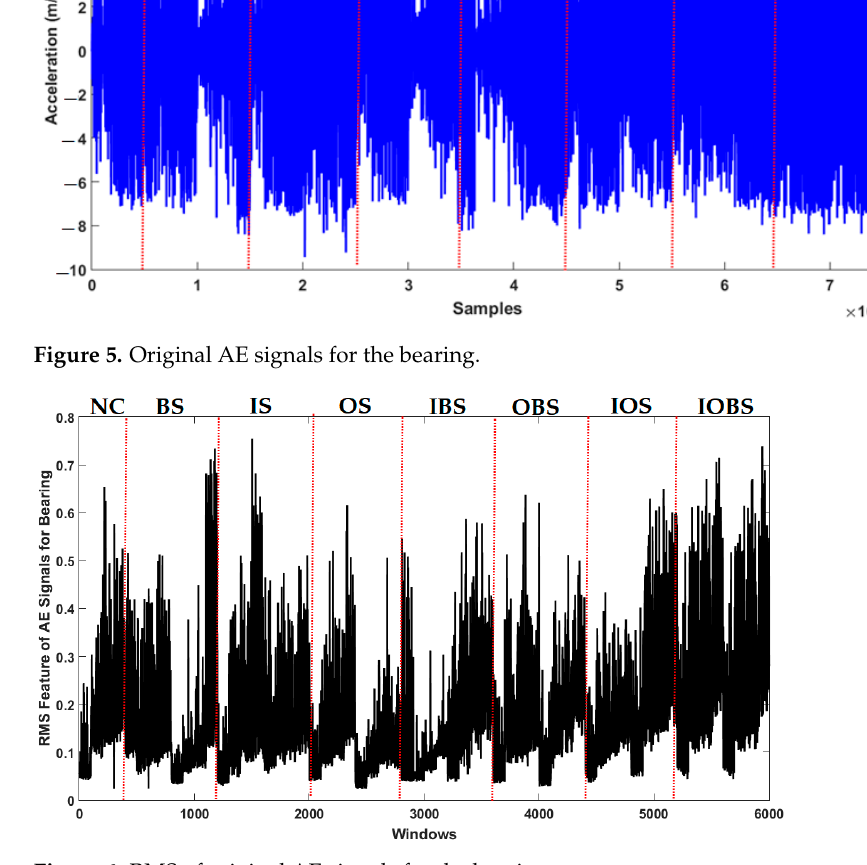
Figure 6. RMS of original AE signals for the bearing.